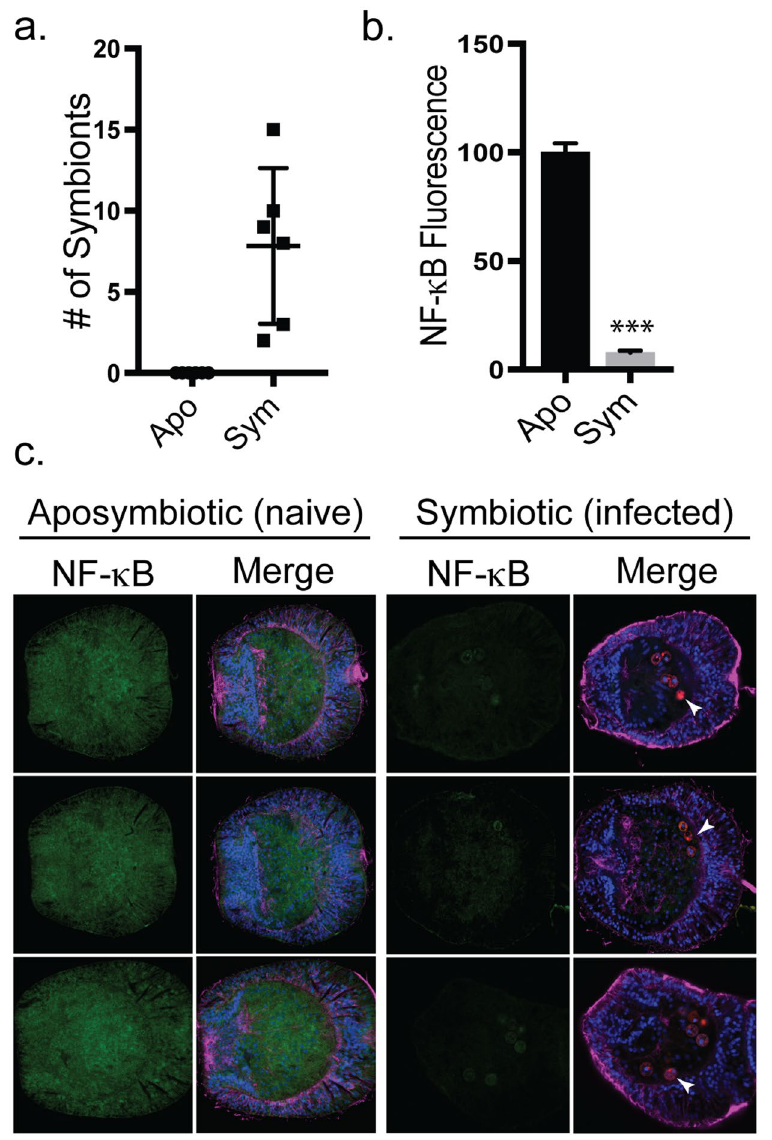
Figure 5. Infection with Symbiodinium reduces NF- κ B expression in Aiptasia larvae. ( a ) NF- κ B protein levels were measured by indirect immunofluorescence of aposymbiotic larvae and larvae infected with SSB01 Symbiodinium . The number of symbiont cells in individual larvae were counted by manually scanning through the z-plane in confocal images. Apo, n = 8; Sym, n = 6. No symbionts were seen in Apo larvae. ( b ) Ap-NF- κ B fluorescence in Apo and Sym Aiptasia larvae was quantified using Corrected Total Cell Fluorescence (CTCF) of confocal images measured using ImageJ. Values are relative to the CTCF value of Apo larvae (100). Five larvae were quantified for each group. *** p < 0.0001. ( c ) Representative immunofluorescence images of naïve aposymbiotic larvae and larvae infected with Symbiodinium . NF- κ B panels, NF- κ B staining alone. Merged panels: Green, NF- κ B; Blue, nuclei; Red, Symbiodinium (e.g., white arrows); Magenta, α